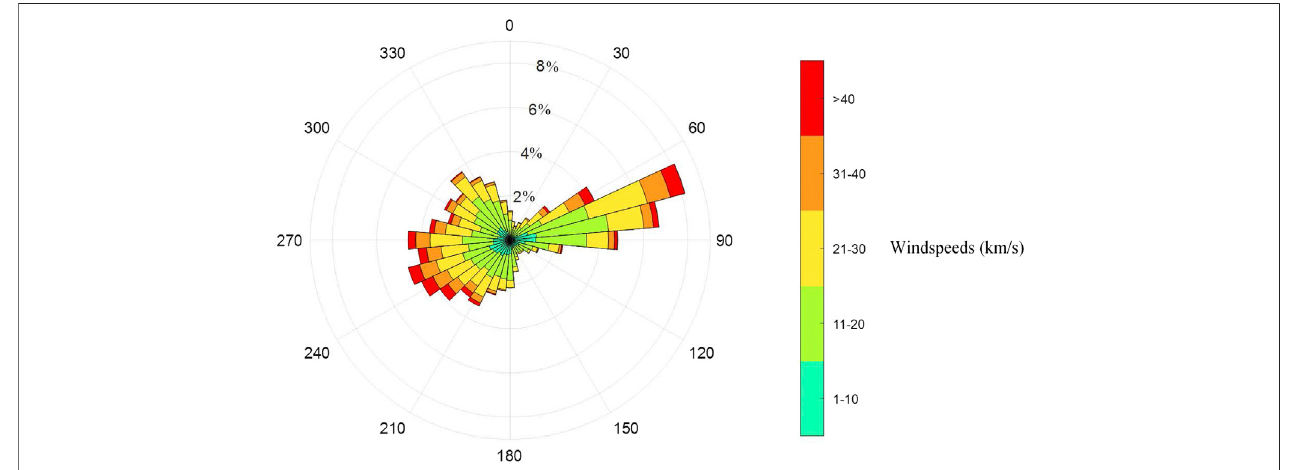
FIGURE 12 | Windspeed distribution at Billy Bishop